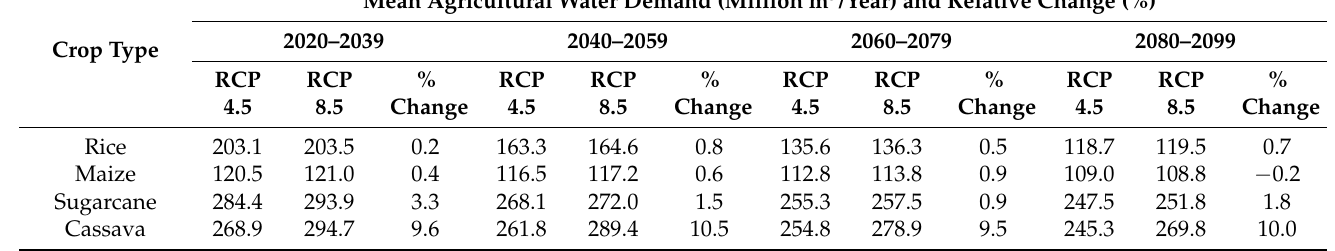
Table 5. Changes in agricultural water demand for future periods under RCP 8.5 relative to RCP 4.5.